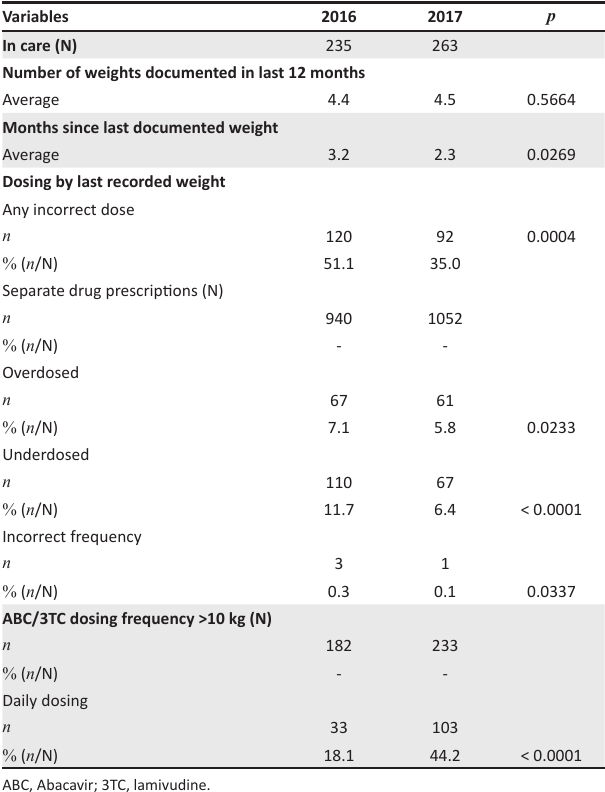
TABLE 3: Weights and